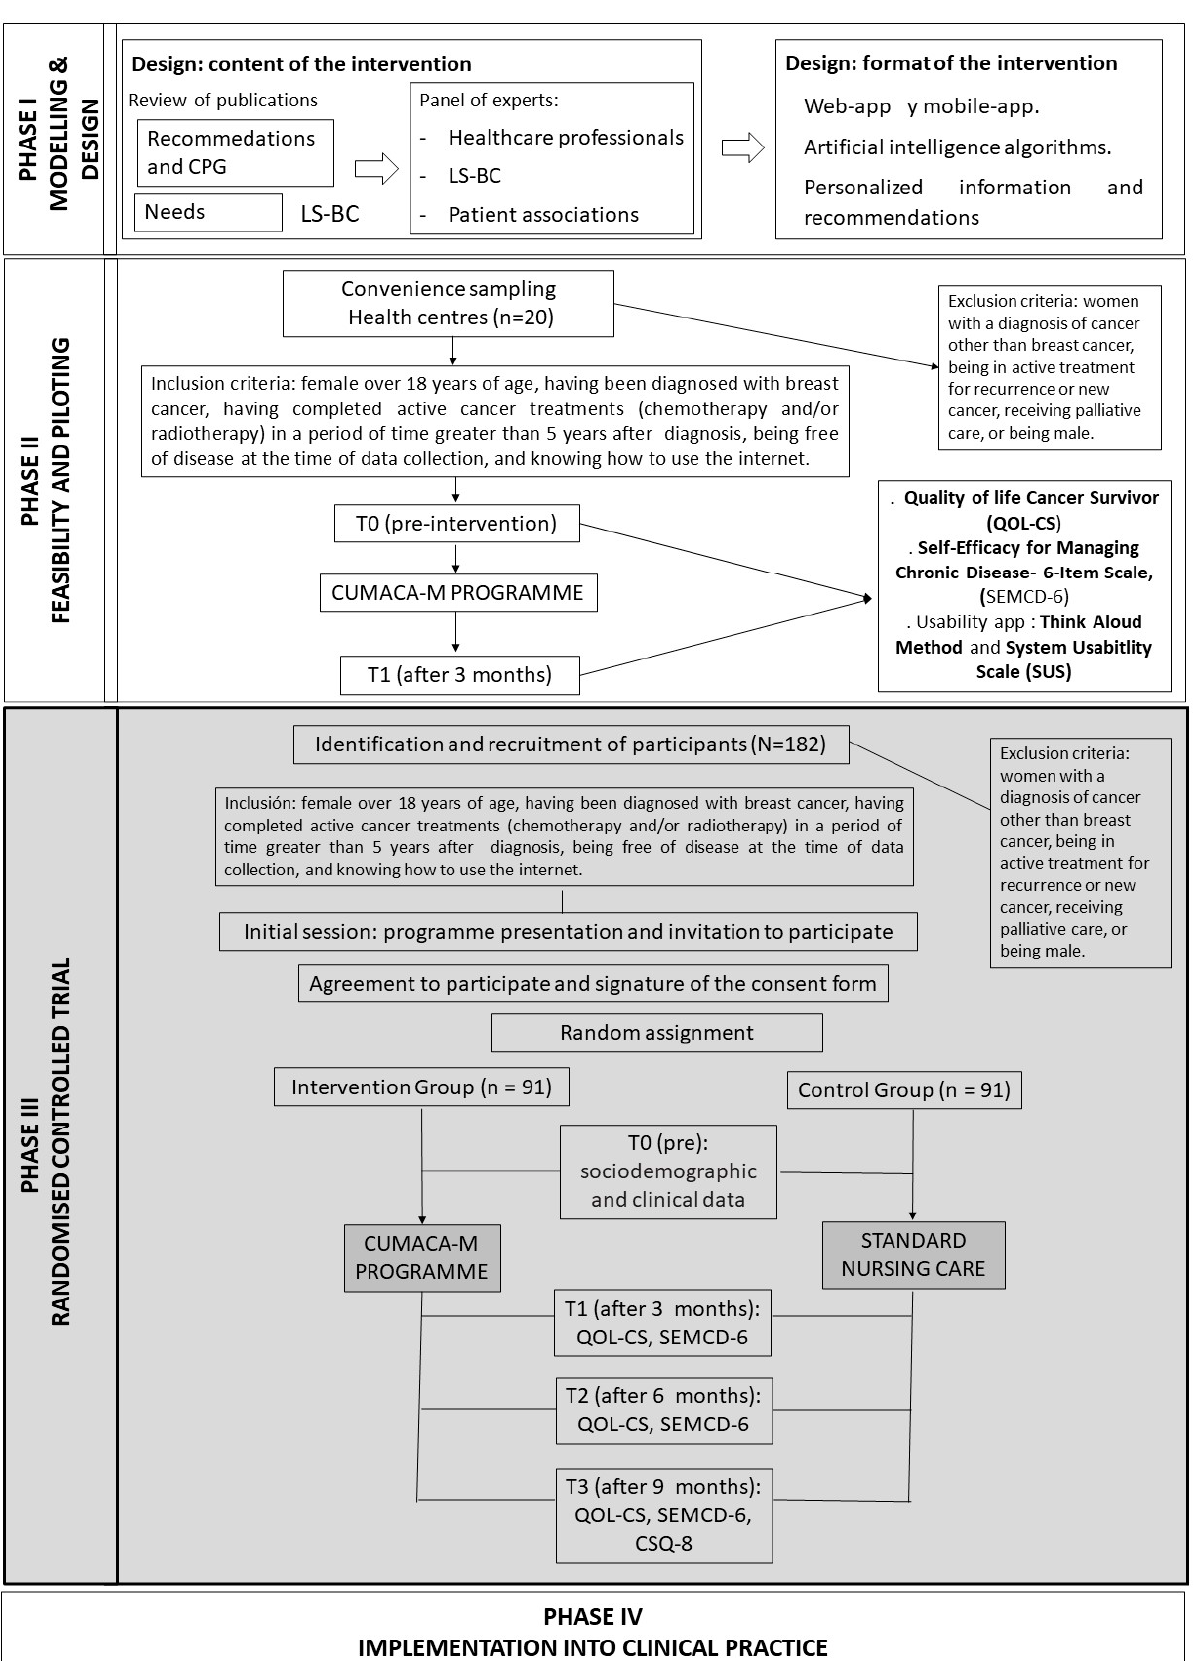
Figure 1. Phases of the study.